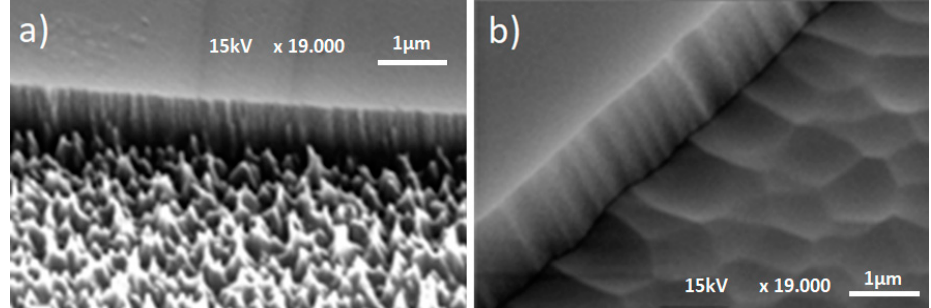
Figure 5. SEM pictures of RIE-etched surface (SF6-Plasma with 20 sccm flow-rate, 270 W, 30 mTorr): ( a ) Before and ( b ) After 15 min of IBE treatment (Ar-ion beam, 1000 V acceleration voltage, 80 mA beam current).